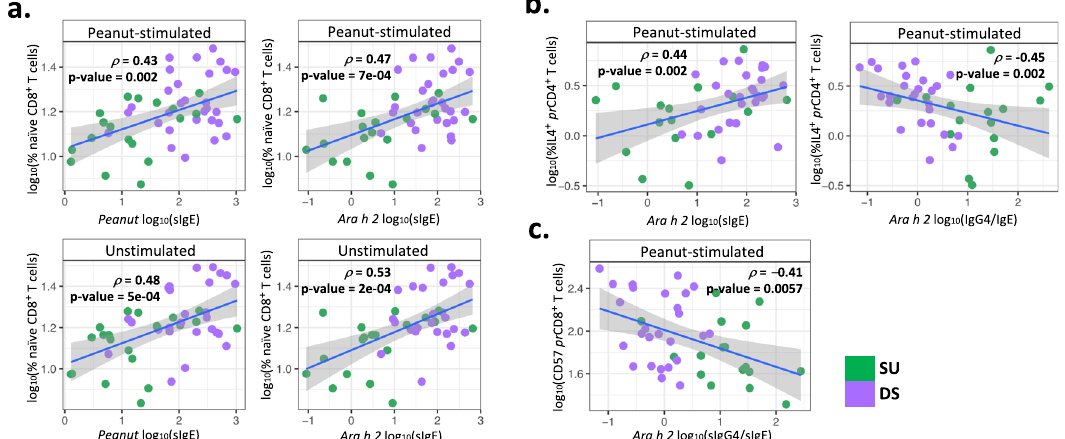
c Spearman correlation of frequency of peanut-reactive CD57 + CD8 + cells within totalprCD8 + Tcellsinpeanut-stimulatedPBMCswithArah2-speci fi cIgG4/IgEratio at BL (pea stim: SU, n =20, DS, n =29; unstim: SU, n =20, DS, n =26). Data are presented asthe mean±SE. p values in the fi gure were determined by anunpaired two-tailed Student ’ s t test. Plots display the correlation coef fi cient ( ρ ) and linear regressionlinewitha95%con fi denceintervalshading.Sourcedataareprovidedas a Source Data fi